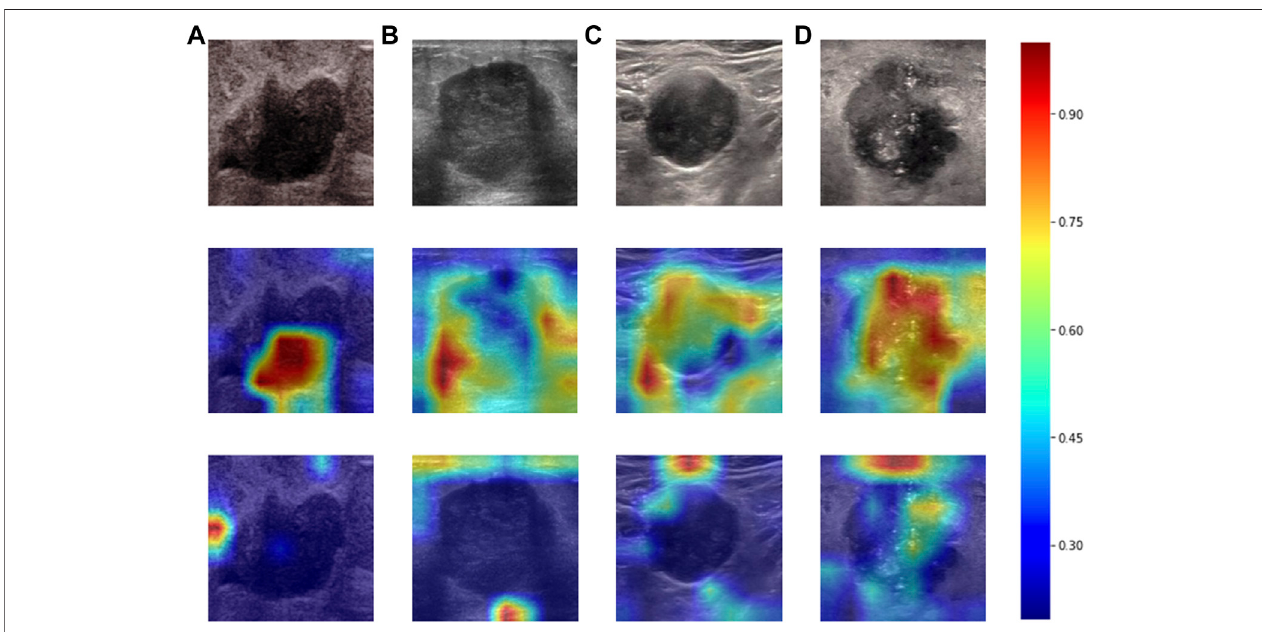
FIGURE 6 | Heatmaps produced using Grad-CAM. The fi rst row (A – D) shows US images from patients with ALNM. The second row shows heatmaps generated fromourmodelthatperformedALNMpredictionandmalignancyprediction.ThethirdrowshowsheatmapsgeneratedfromthemodelperformingonlyALNMprediction.